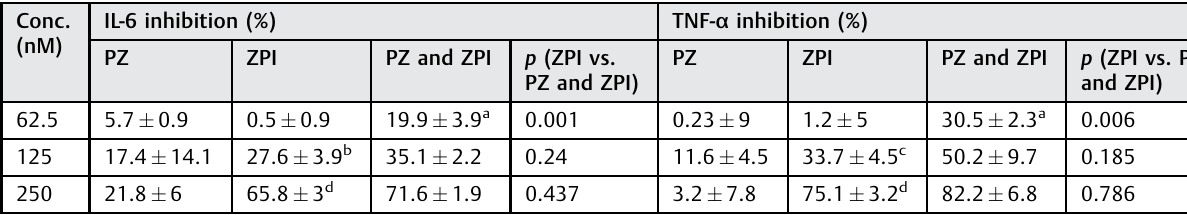
Table 1 Effects of puri fi ed protein Z (PZ) on the inhibitory effects of recombinant human ZPI (rhZPI) on the secretion of IL-6 and TNF- α in LPS-stimulated whole blood Conc.